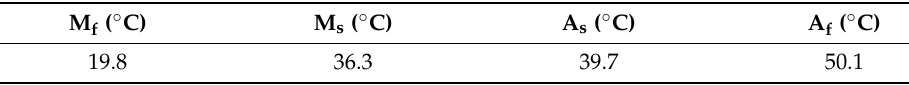
Table 2. Phase transition temperatures of NiTi